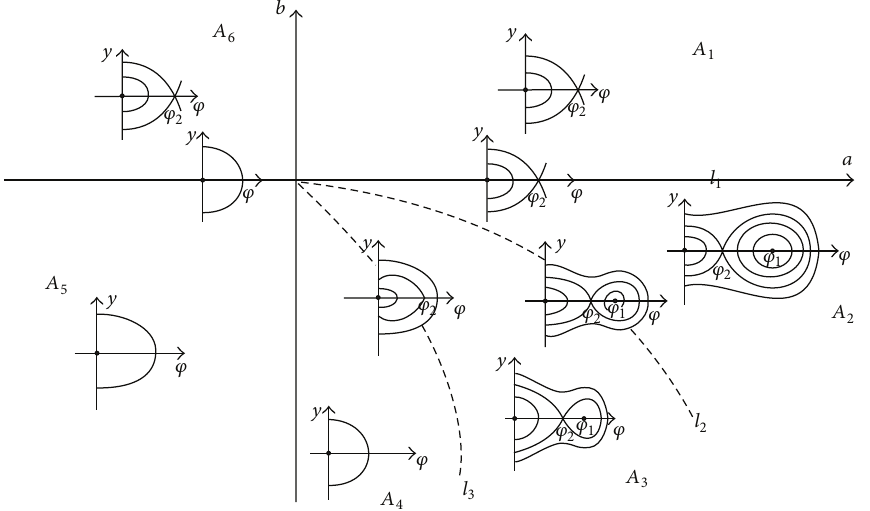
Figure 2: The bifurcation phase portraits of system (7) when 𝛿 < 0